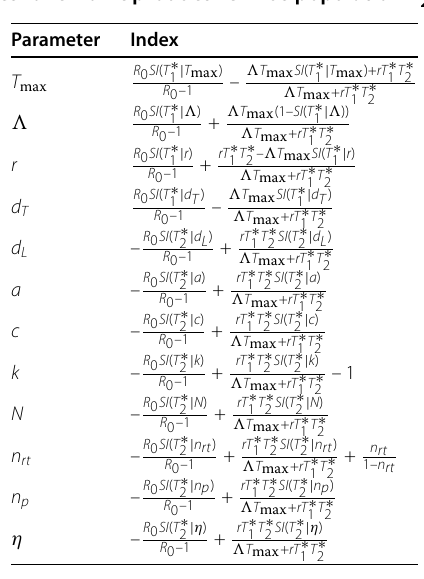
Table 6 Sensitivity indices for chronic productive virus population V ∗